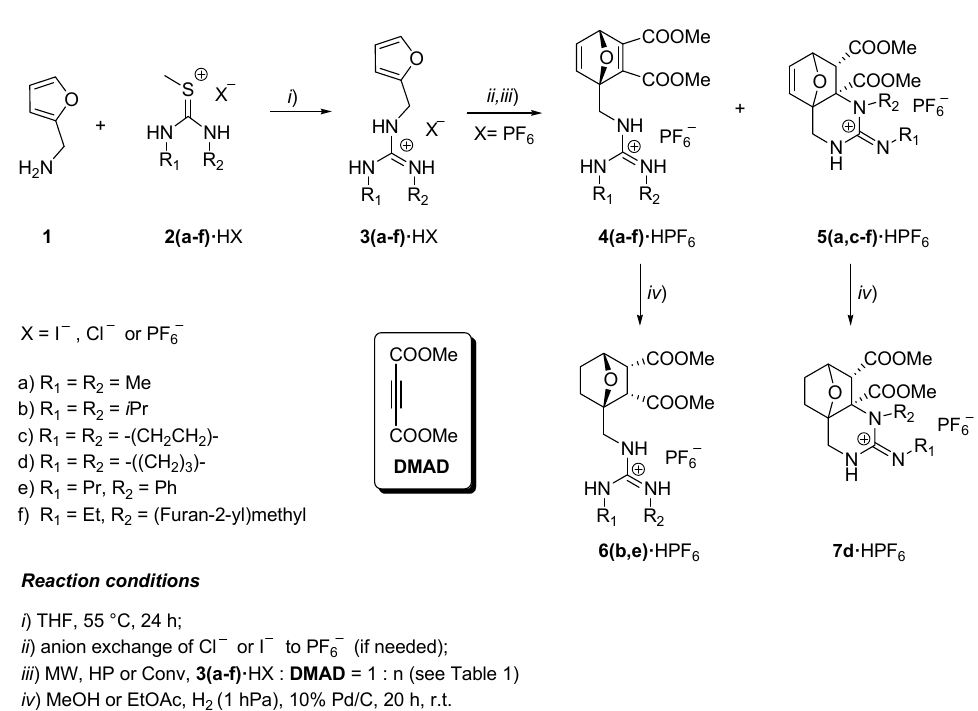
Table 1. Employed reaction conditions, product ratios, conversion, and isolated yields in the reac- tion of furfurylguanidinium hexafluorophosphates with DMAD .